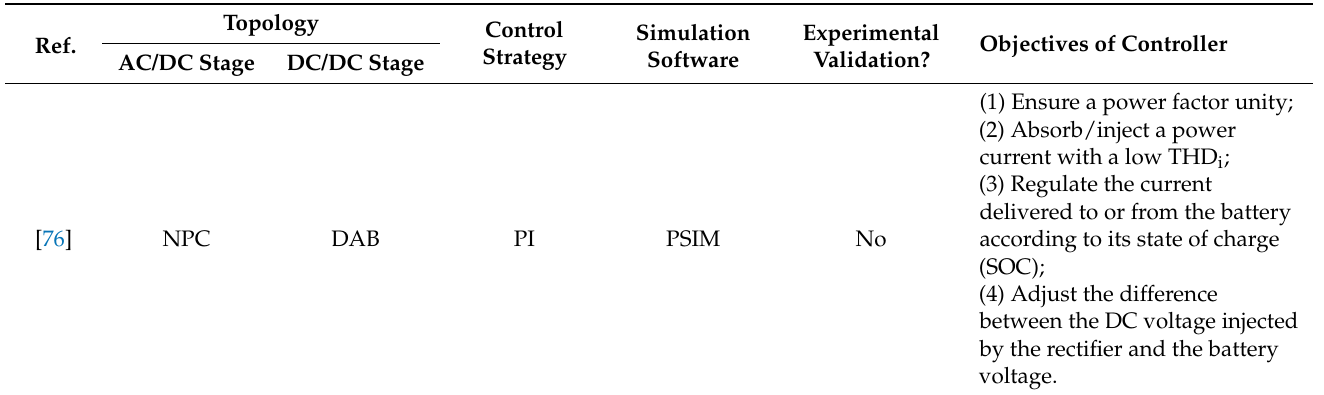
Table 6. Linear control techniques proposed for ultra-fast chargers in the